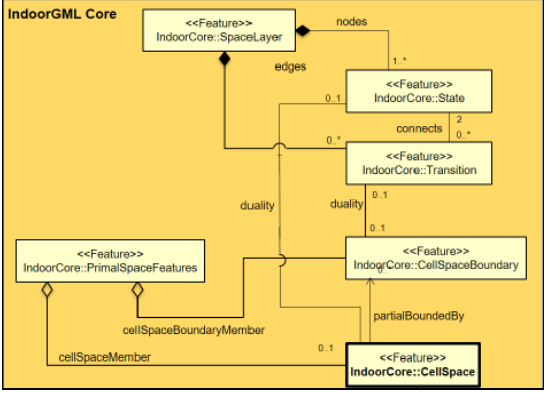
Figure 7. Geometry in IndoorGML (Jiyeong Lee,